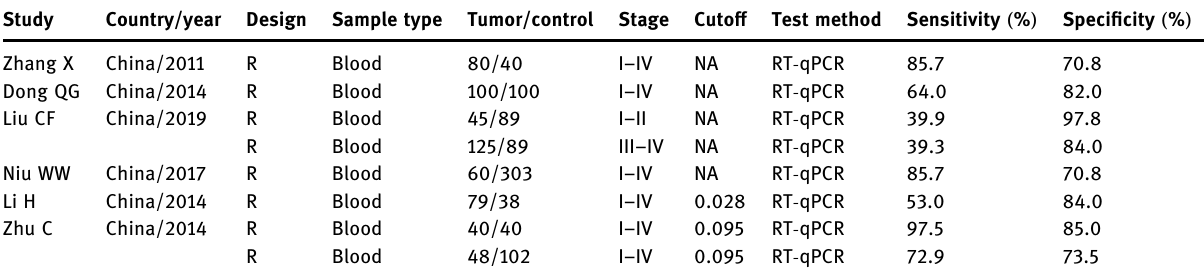
Table 1: Characteristics of the studies that related to the diagnosis of gastric cancer